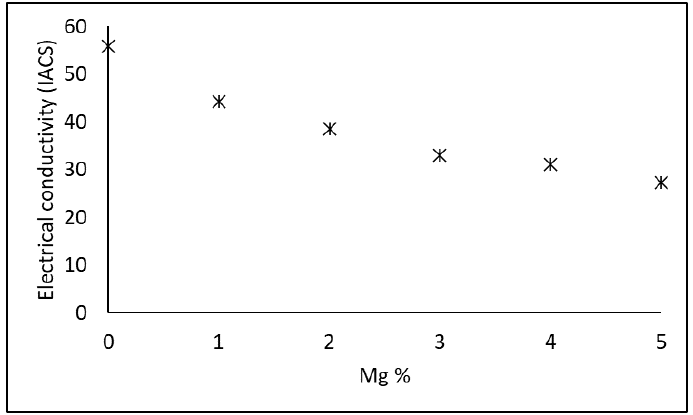
Figure 4. The electrical conductivity vs. Mg content percentiles based on the averages at each condition. Table 9. One-way ANOVA for the effect of Mg percentage on the electrical conductivity. Table 8. The results of two-sample t-test for the electrical conductivity values. Analysis of